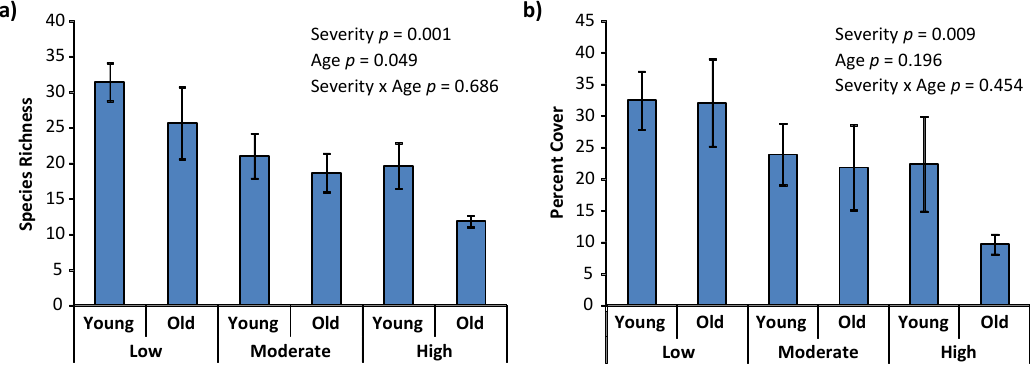
Figure 2. ( a ) Species richness (total number of plant species found in each stand) and ( b ) percent cover (total cover of all species averaged from four 1 m × 1 m quadrats per stand), in relation to burn severity (as measured by the Composite Burn Index) and pre ‐ fire stand age.